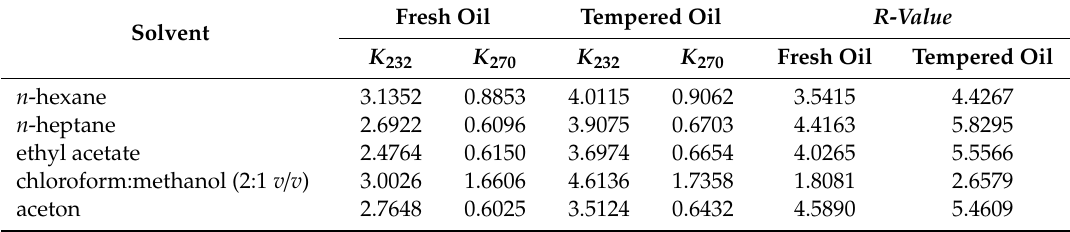
Table 3. The extinction coe ffi cient of fresh and tempered oils at 232 and 270